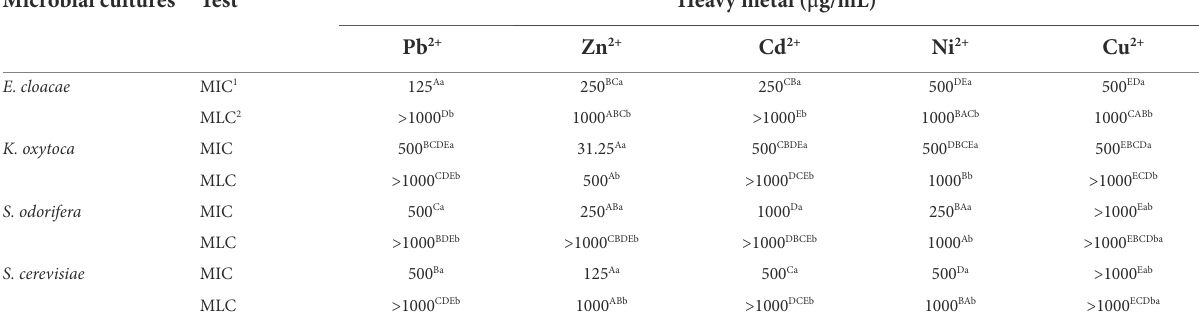
TABLE 2 Resistance of isolated and identified microorganisms in planktonic form to selected HMs expressed as MIC and MLC. Microbial cultures